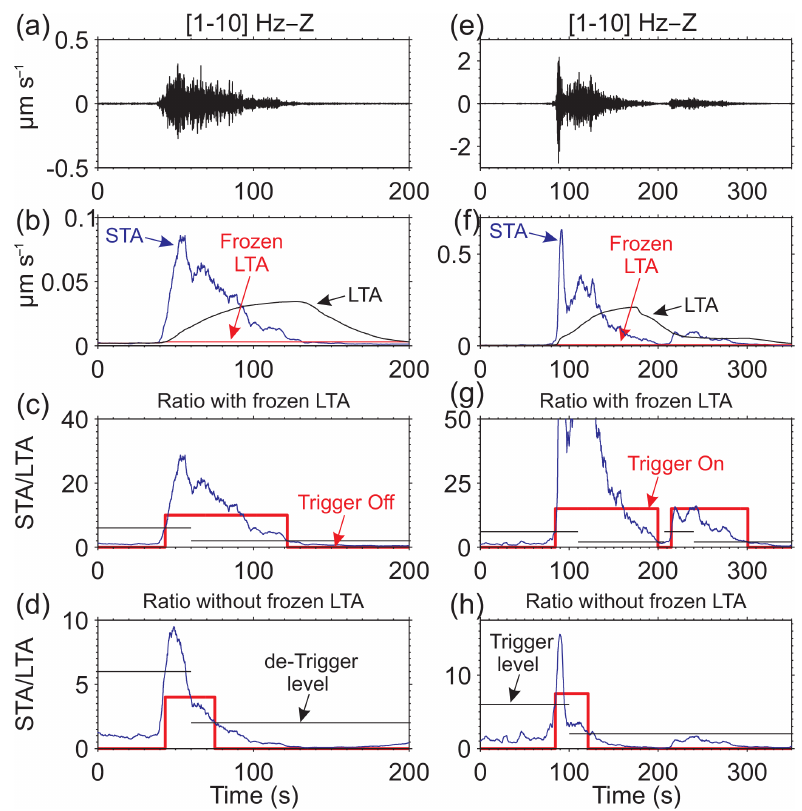
Figure 9. STA/LTA detection of a rockfall (left) and a rockslide (right). ( a , e ) [1–10]Hz band-pass-filtered recording; ( b , f ) STA, LTA and frozen LTA for the processed event; ( c , g ) STA/LTA ratio with a frozen LTA; and ( d , h ) STA/LTA ratio with a continuously updated LTA. The horizontal black lines represent the trigger (upper-level) and de-trigger (lower-level) threshold. The red box function illustrates the trigger state of the detection on/off